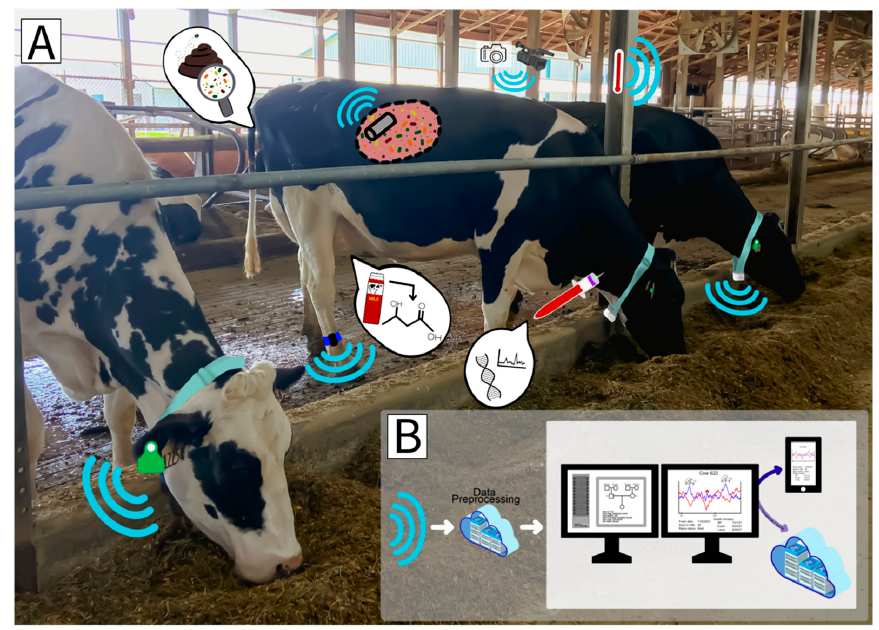
Figure 1. Overview of precision technologies, high ‐ throughput assays and genetic data that could be applied commercially in the improvement of feed intake and efficiency. ( A ). Sensing technologies in use today include wearable sensors, such as milking collar, leg band and ear tag ‐ based sensors with accelerometers, temperature sensors, and proximity sensors; image ‐ based monitoring systems;